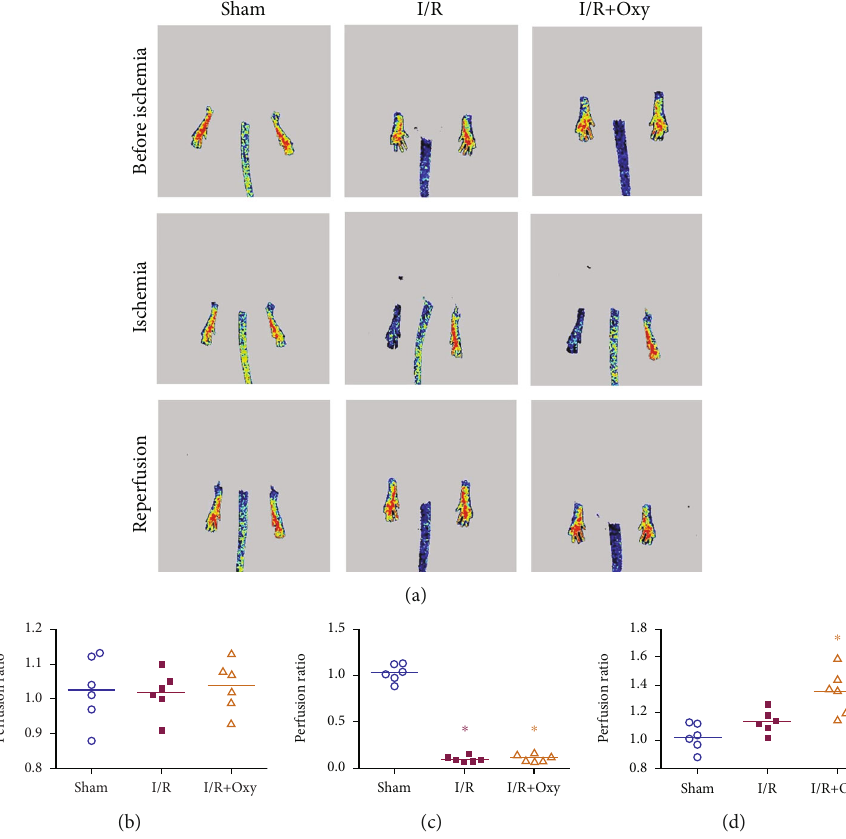
Figure 1: Oxy treatment increased blood fl ow after tourniquet placement on the hind limb. (a) Representative images of blood perfusion in the mouse hind limb obtained using laser speckle contrast imaging. The red color on the image represents high blood fl ow to the limb while the blue color represents low blood fl ow. Quanti fi cation of perfusion in the ischemic hind limb before ischemia (b), during ischemia (c), and during reperfusion for 24 h (d). I/R: ischemia-reperfusion; Oxy: oxycodone. Data are expressed as the mean ± SEM ( n = 6 in each group); ∗ P < 0 : 05 vs.